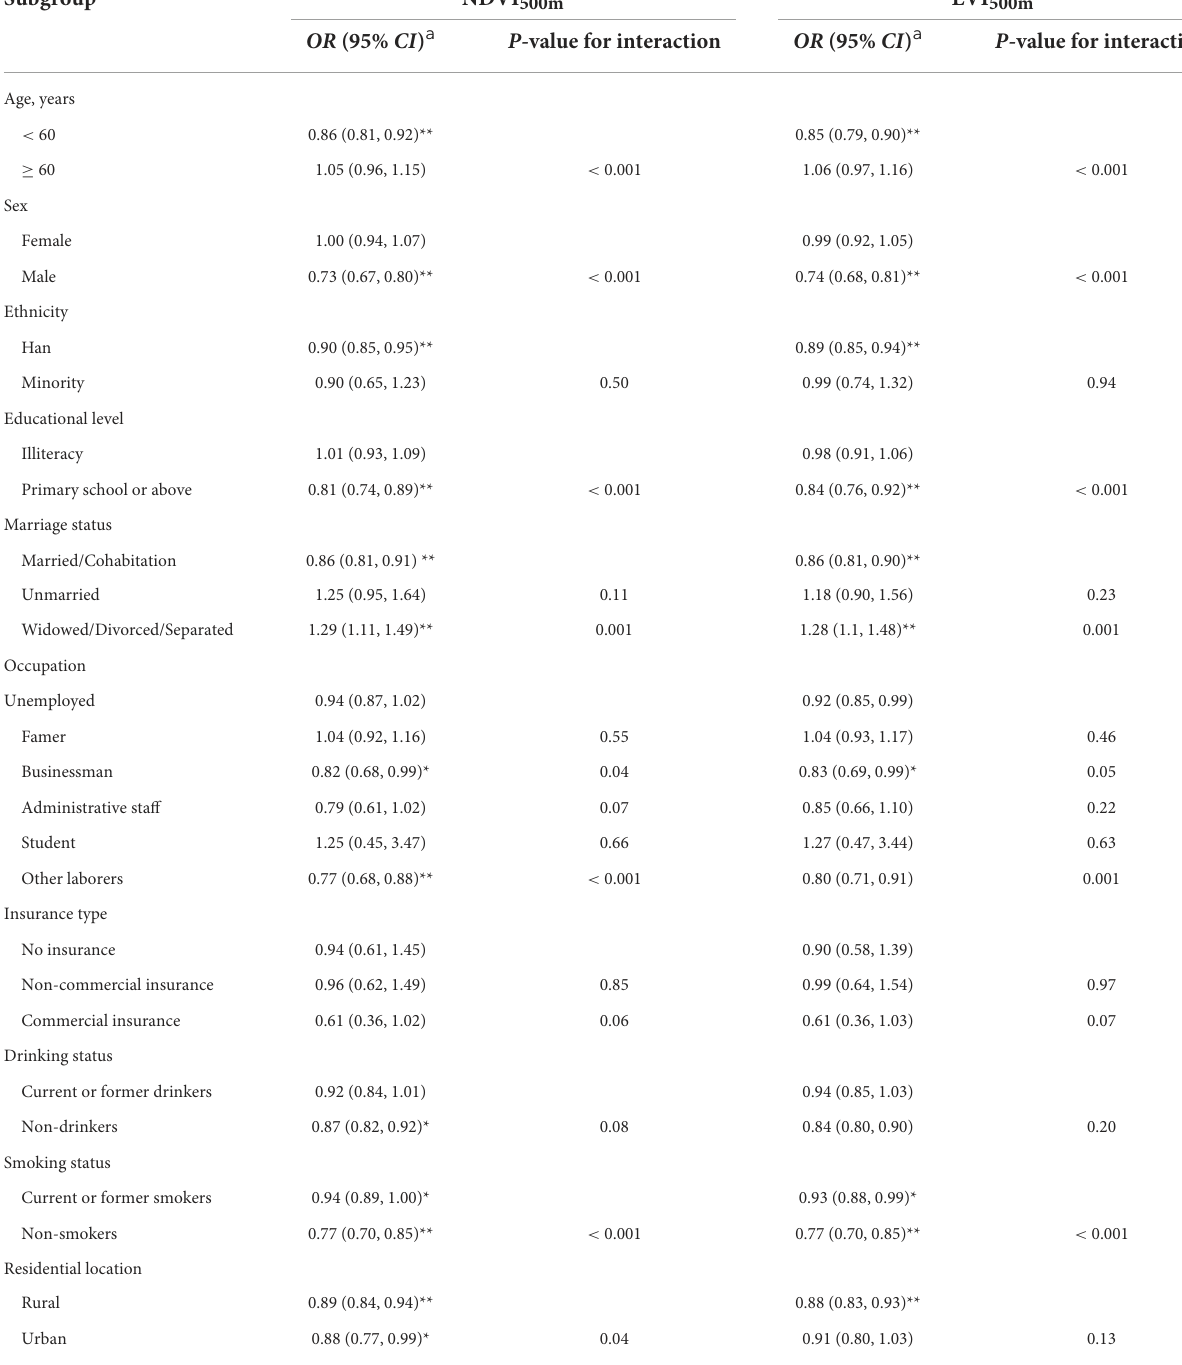
TABLE 3 Associations between residential greenness exposure and MetS risk stratified by potential modifiers. Subgroup NDVI